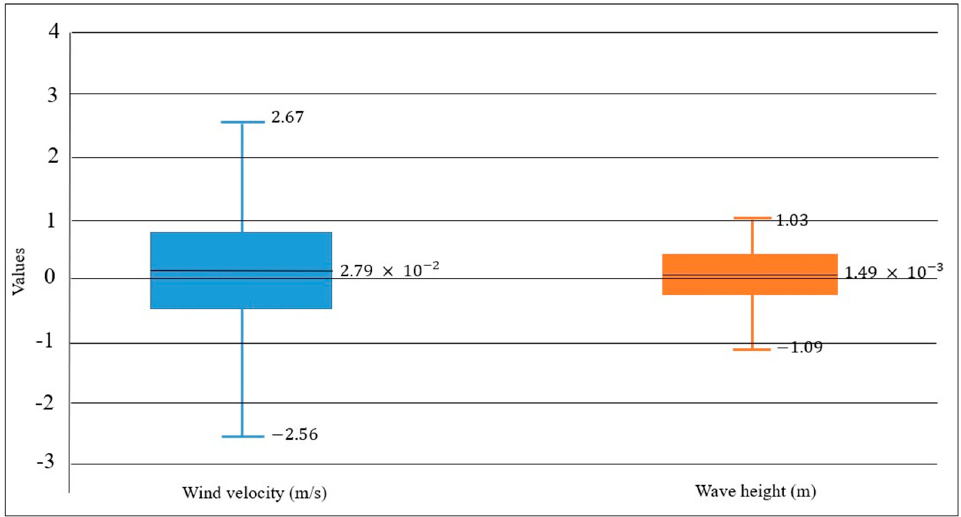
Figure 9. The box plot of raw data for presenting the outliers.